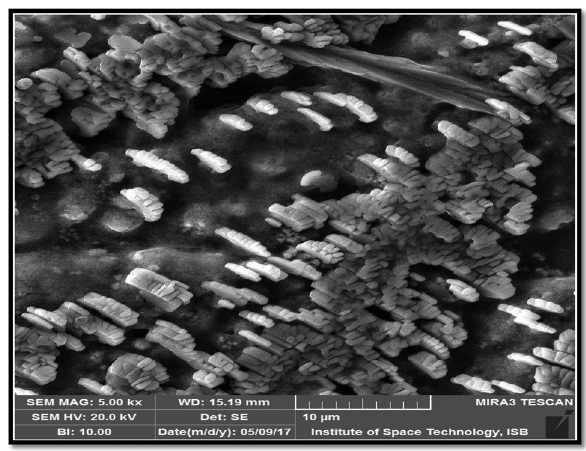
Figure 6: SEM of AgNPs showing morphology of AgNPs.